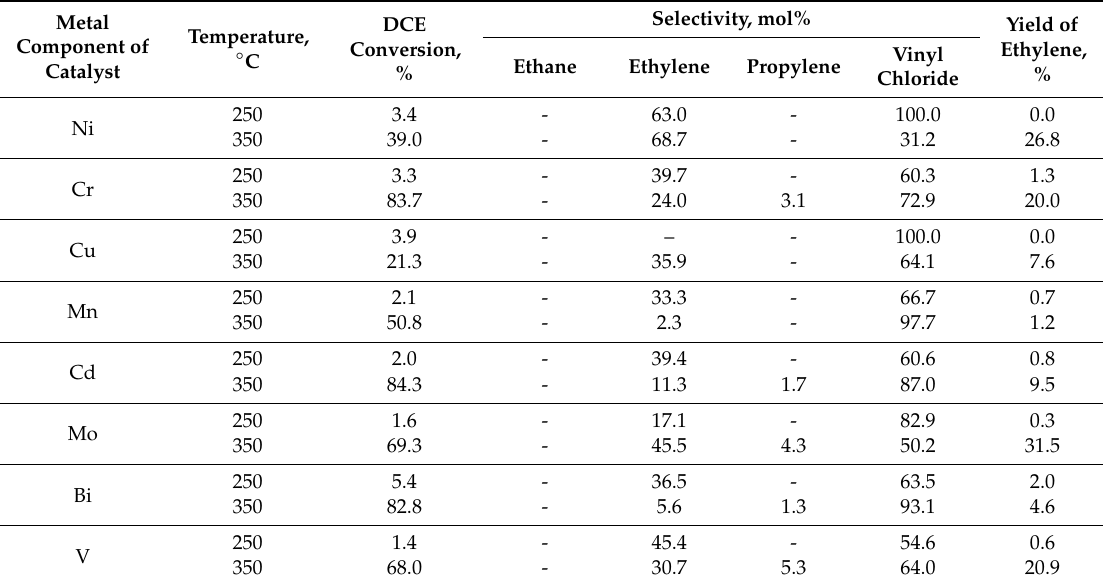
Table 10. Results of 1,2-dichloroethane conversion on catalysts (Me / Al 2 O 3 ) with a variable metal